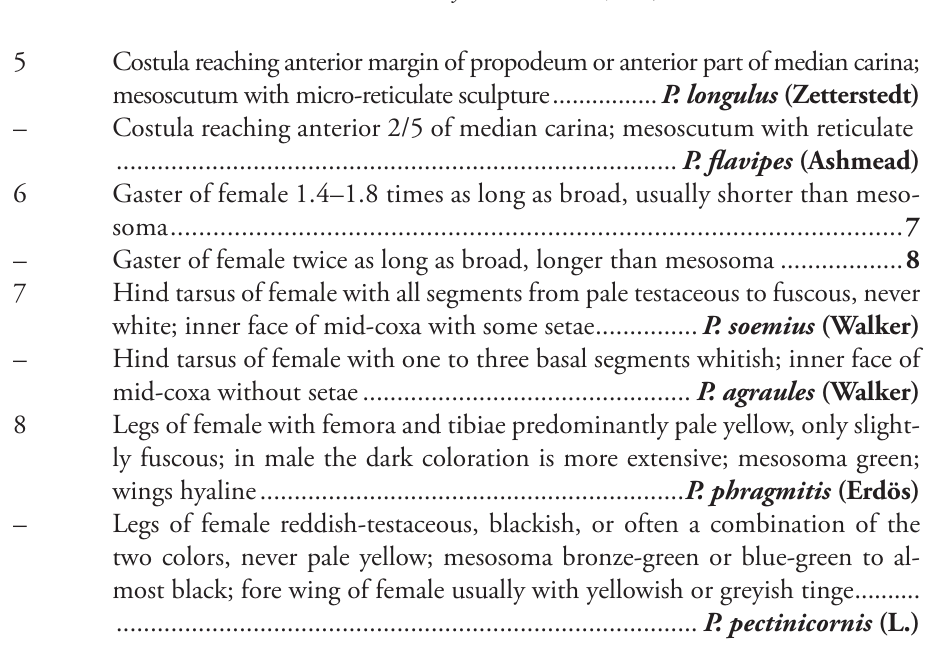
(Fig. 6) or if present, then weak and not reaching median carina (Fig. 9, arrow). Fore wing (Fig. 11) length 2.7 × width; costal cell length 10.0 × width. Hind coxa (Fig. 7) coarse reticulate dorsally; hind femur, tibia (apical portion brown), yellow to yellowish